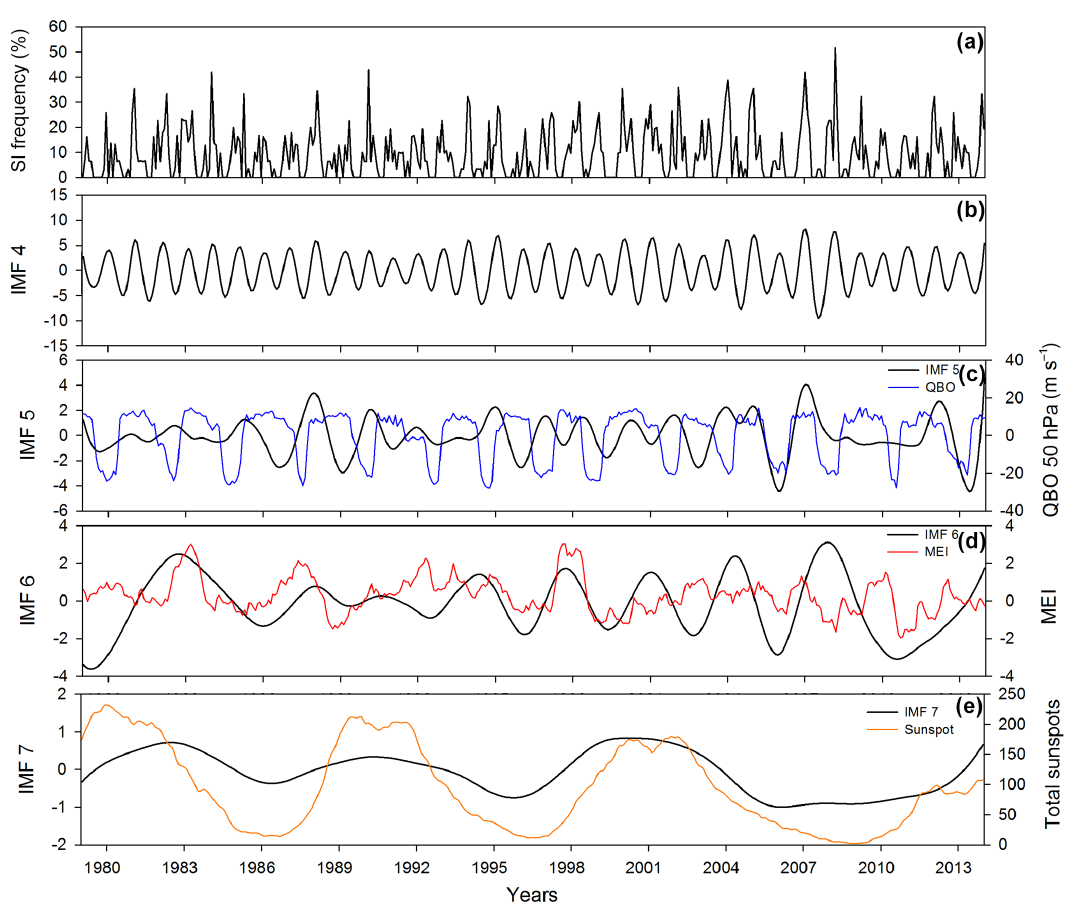
Figure 6. Same as Fig. 5 but for Mt. Cimone time